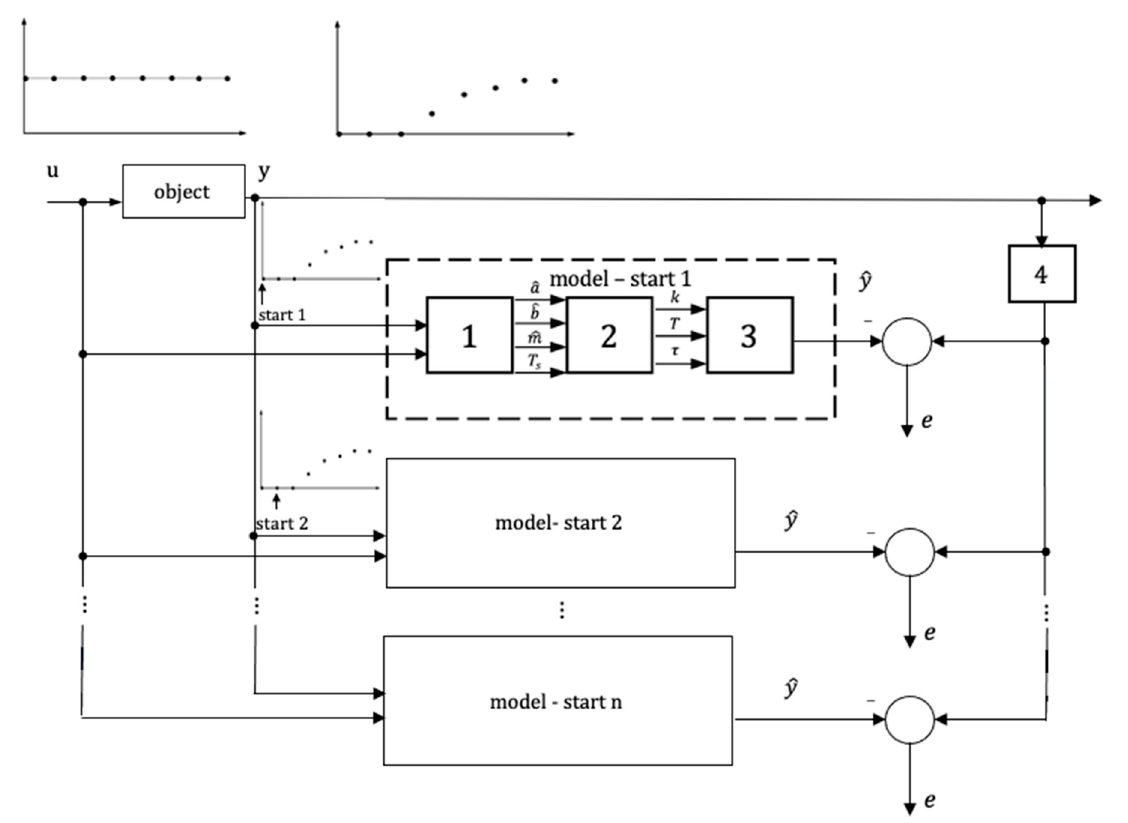
Figure 4. Idealized block diagram of a method for identifying the dynamic properties of the coal flotation process with the use of Kalman filter. 1—estimation of the coefficients of Equation (2) with the use of Kalman algorithm, 2—block for converting the coefficients of Equation (2) into model parameters (1), 3—block for determining the step response of the model, and 4—block for recording the signal y during the measurement experiment.